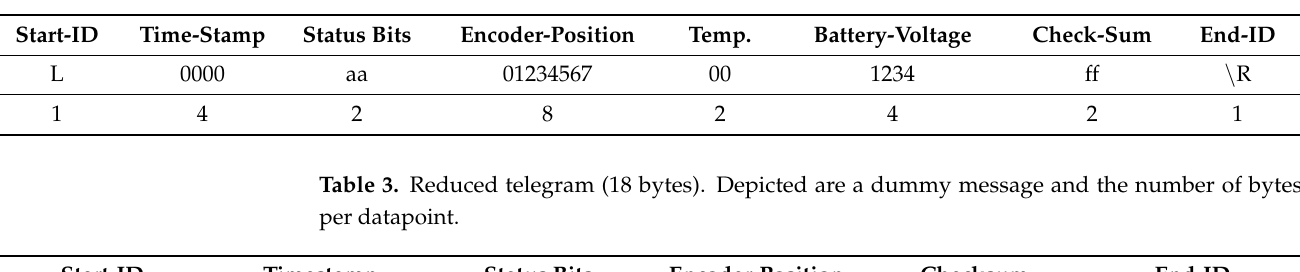
Table 2. Full telegram (24 bytes). Depicted are a dummy message and the number of bytes per datapoint.